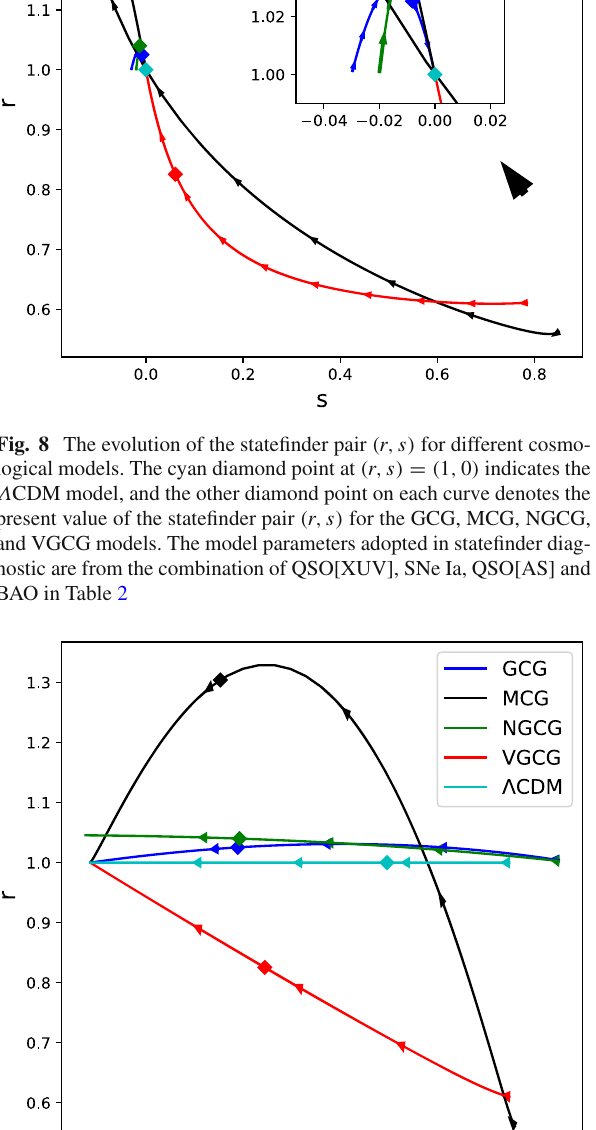
the Bayes information criterion [91], and the deviance infor- mation criterion [92], would be